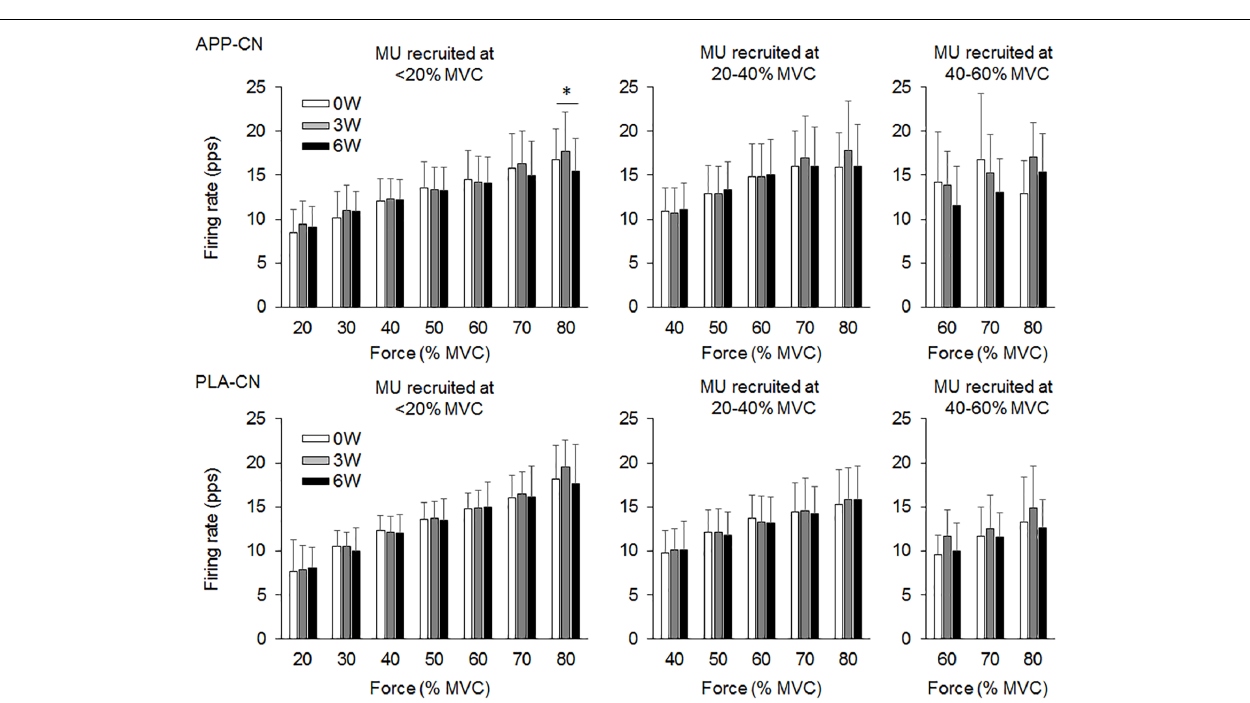
FIGURE 2 | Motor unit firing rates of the group with fish protein intake (APP-CN) and the group with the placebo (PLA-CN). MU, motor units. The symbol ∗ indicates significant differences ( p < 0.05) among the periods.